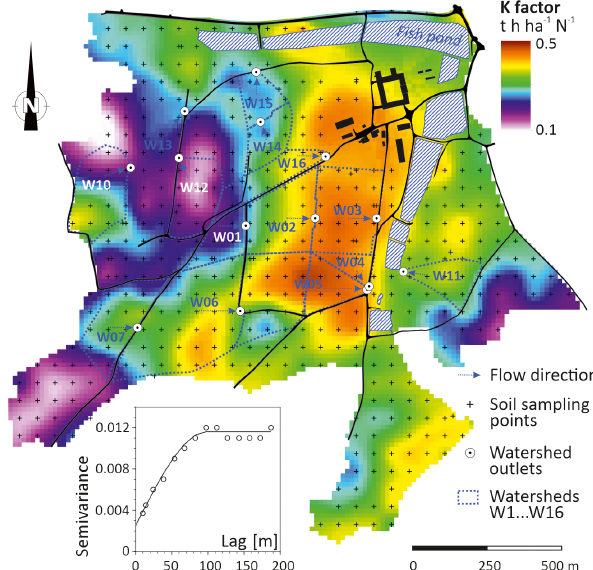
mined according to Wischmeier et al. (1971) at the sampling lo- cations from measured soil properties and then geostatistically in- terpolated for 12 . 5m × 12 . 5m blocks. The krige standard deviation was about 0.02thha − 1 N − 1 . The small panel displays the experi- mental semivariogram calculated from 544 sampling locations and a spherical semivariogram